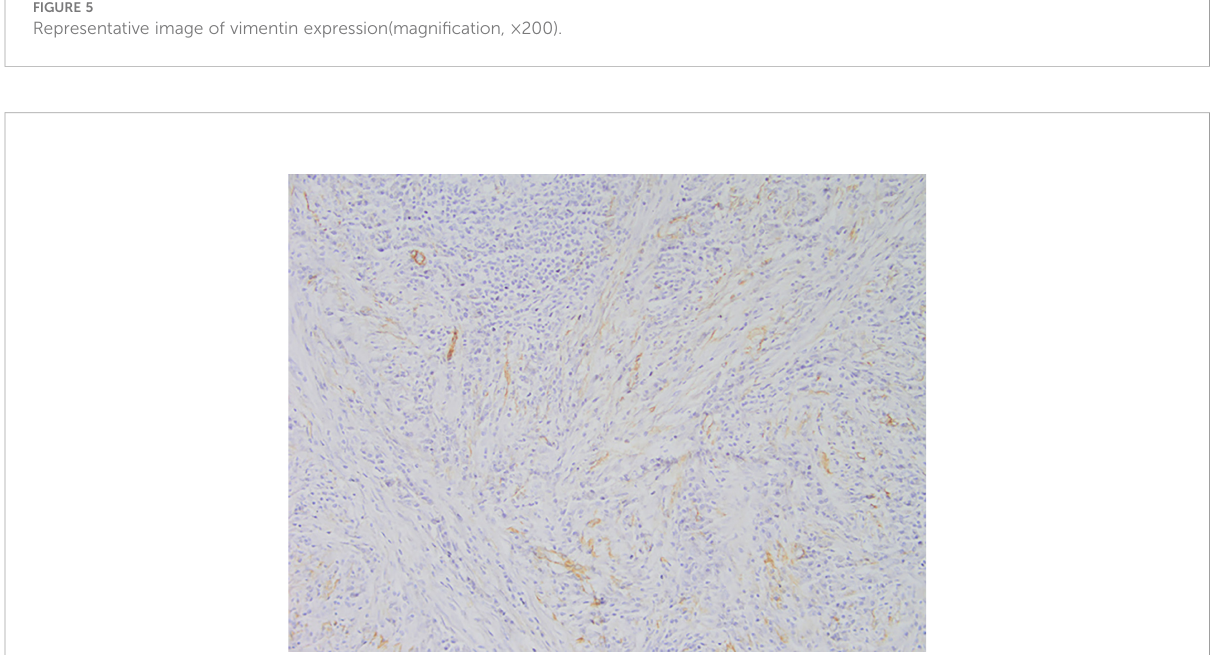
FIGURE 6 Representative image of smooth muscle actin (SMA) expression (magni fi cation,